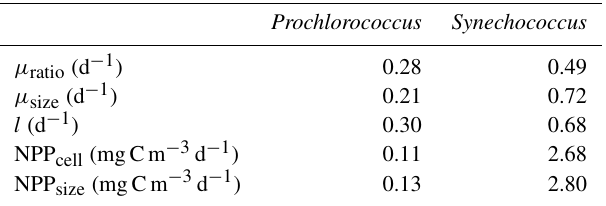
Table 3. Prochlorococcus and Synechococcus daily growth rate estimate ( µ ratio ) computed as the median size ratio µ ratio = ln (v max /v min ) , intrinsic growth rate ( µ size ) and loss rate ( l ) ob- tained from Eq. (7). NPP cell and NPP size biomass production values obtained from Eqs. (8) and (9),